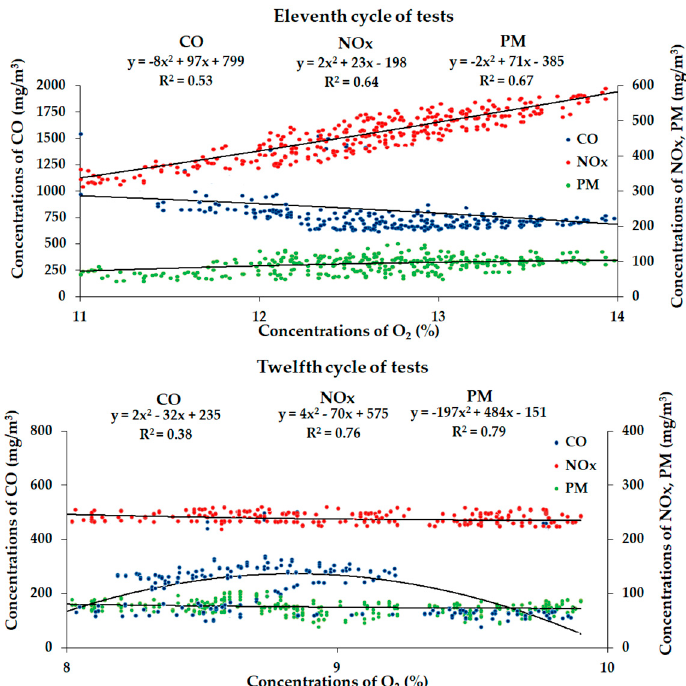
Figure 11. Mass distribution of harmful substances to the remaining amount of oxygen for the eleventh and twelfth cycle of tests.